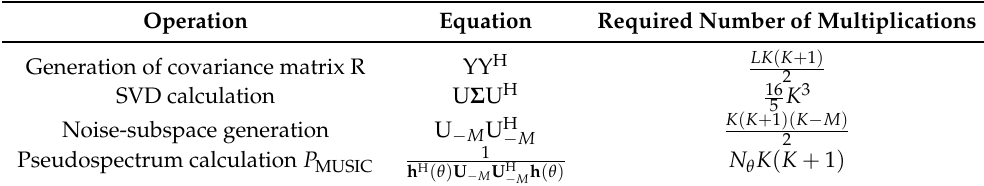
Table 1. Required number of multiplications of main operations for MUSIC algorithm